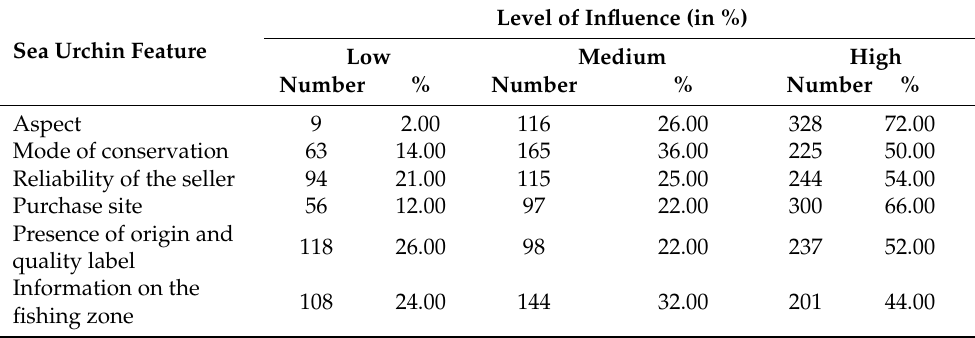
Table 6. Self-level experience with the level of influence of sea urchin features on its purchase price (in % of respondents).